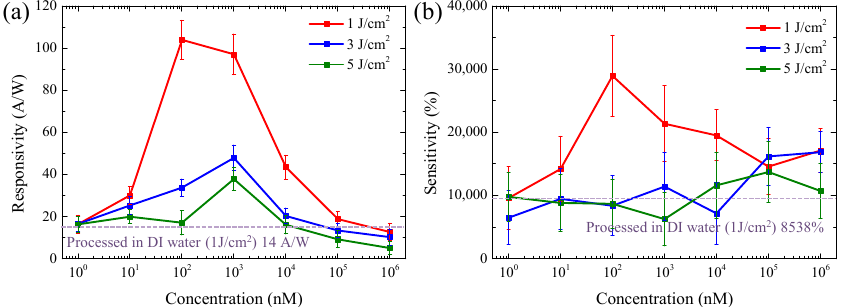
Figure 8. Responsivity and sensitivity with respect to ( a ) AgNO 3 concentration and ( b ) IPL irradia- tion energy. Table 1. Comparison of performances of ZnO nanostructure UV PDs decorated with metal NPs.